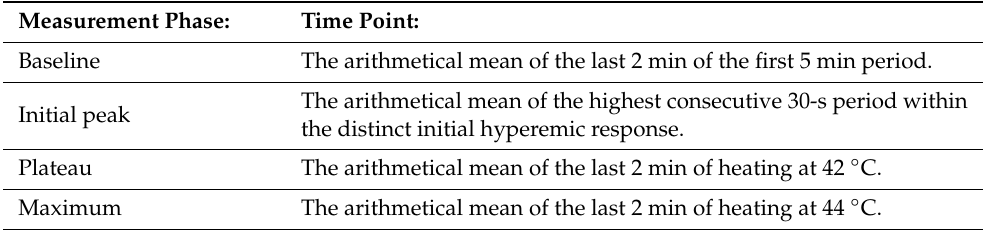
Table 2. Laser Doppler flowmetry measurement phase